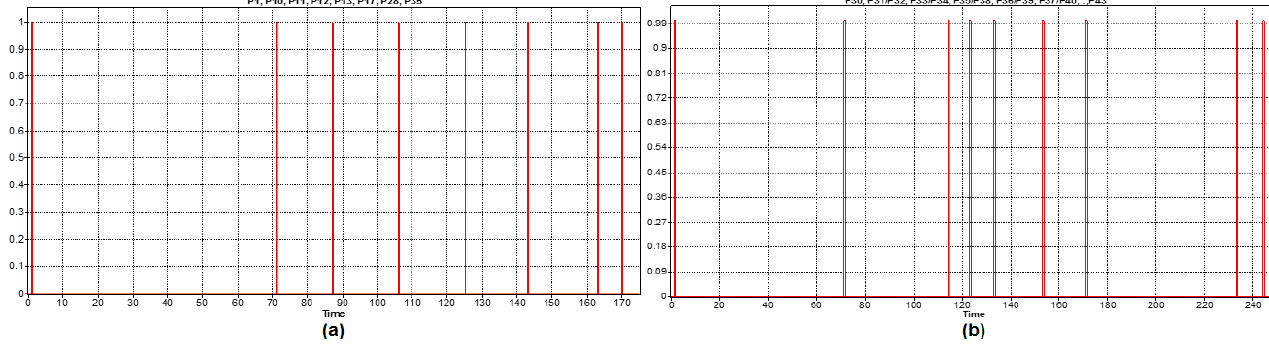
Figure 15. Monitoring signals in PN Sirphyco simulation: ( a ) disassembly WP2, ( b ) repair WP2.